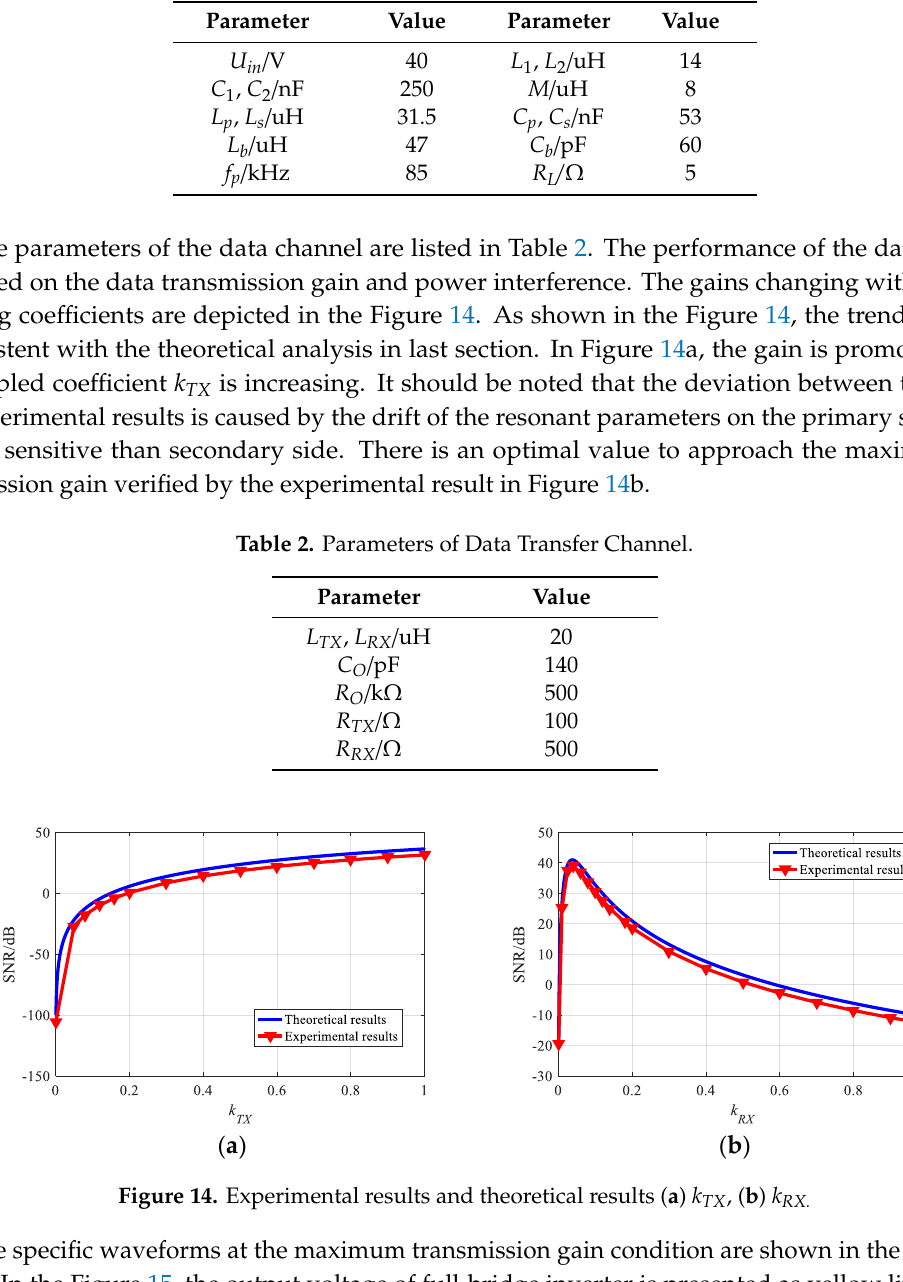
Figure 14. Experimental results and theoretical results ( a ) k TX , ( b ) k RX.